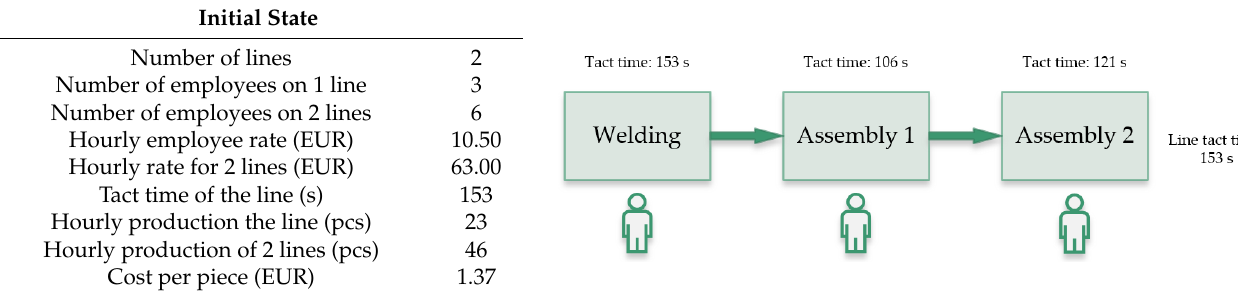
Table 5. Initial state of assembly after snapshot operations.